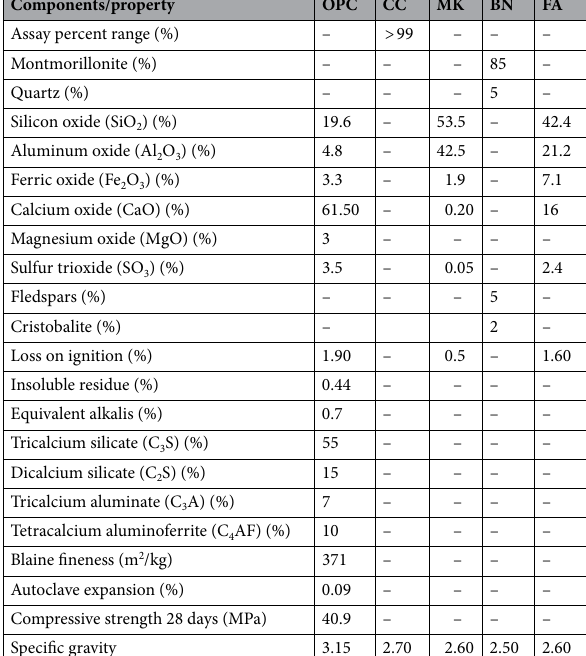
Table 1. Physical and chemical properties of materials used.